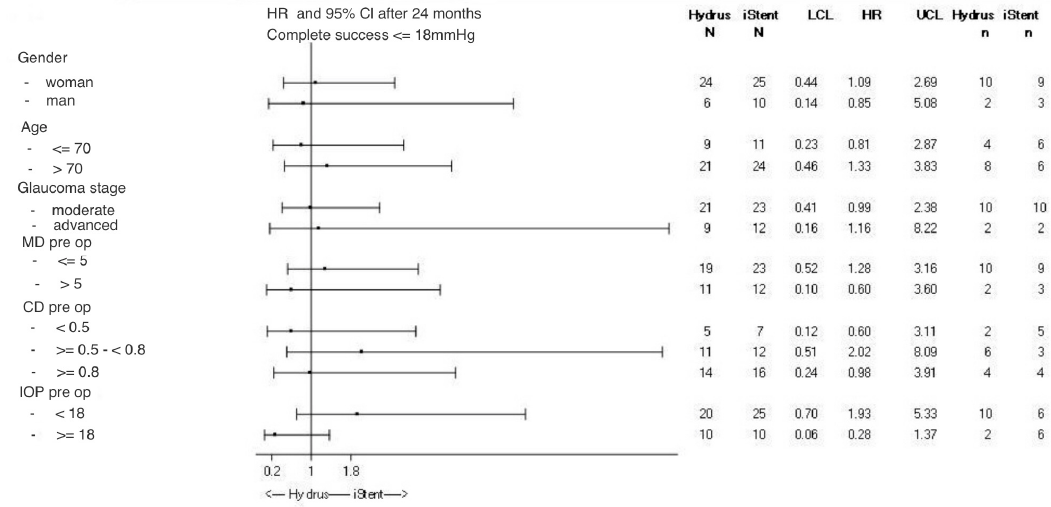
Figure 6. Forest plot for estimation of hazard ratio for Hydrus and iStent at 24 months after